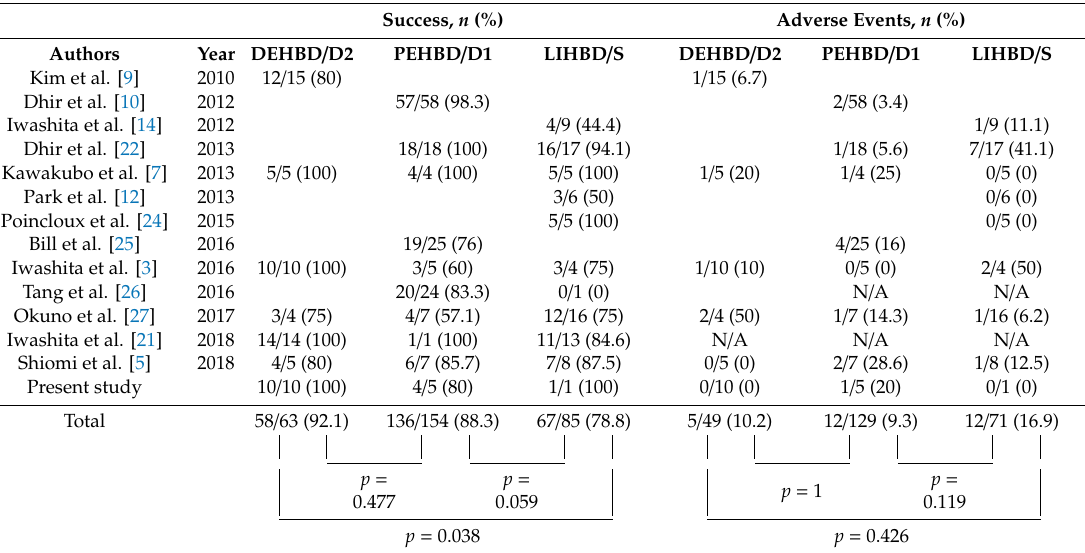
Table 6. Review of published studies with ≥ 5